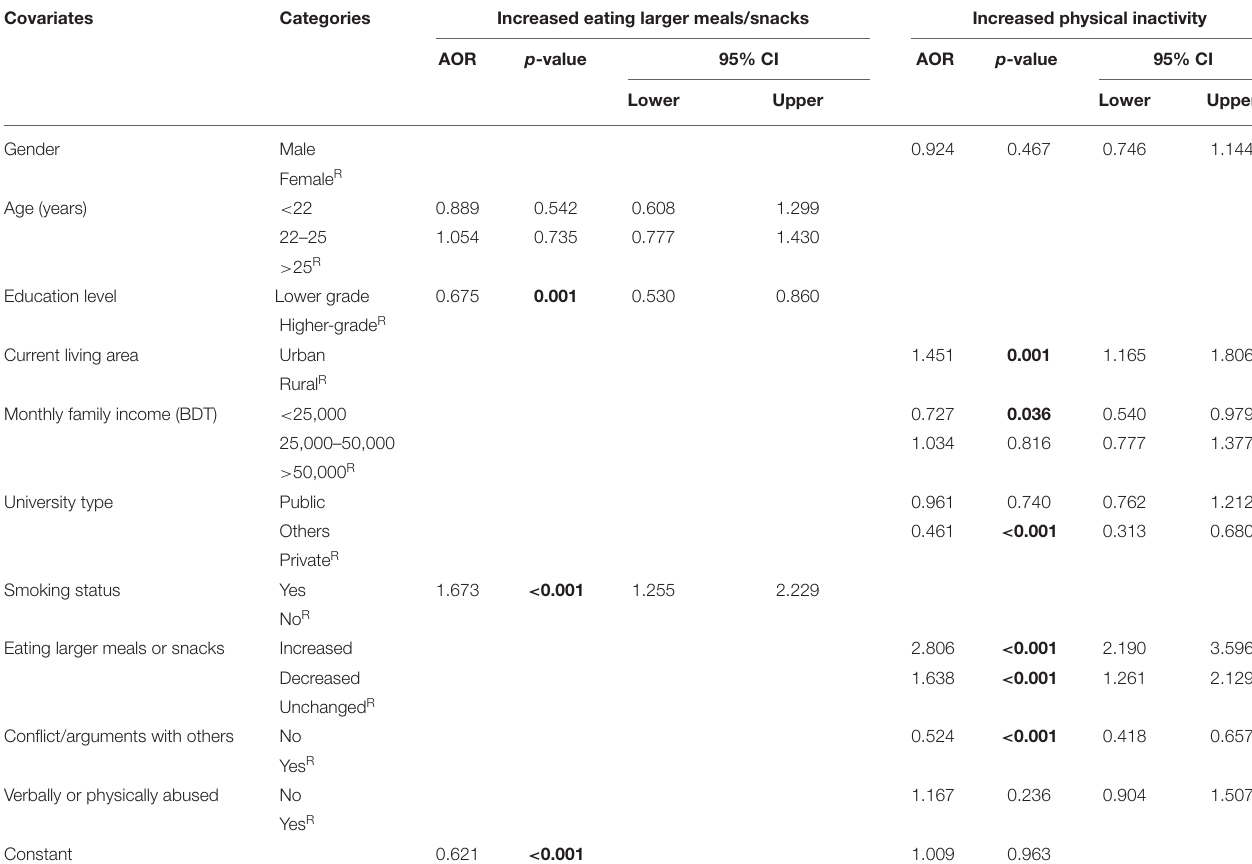
TABLE 5 | Logistic regression analysis for finding the potential associated factors with “conflict/arguments with others” and “physically or verbally abused by others” following prolonged COVID-19 lockdown among Bangladeshi university students.